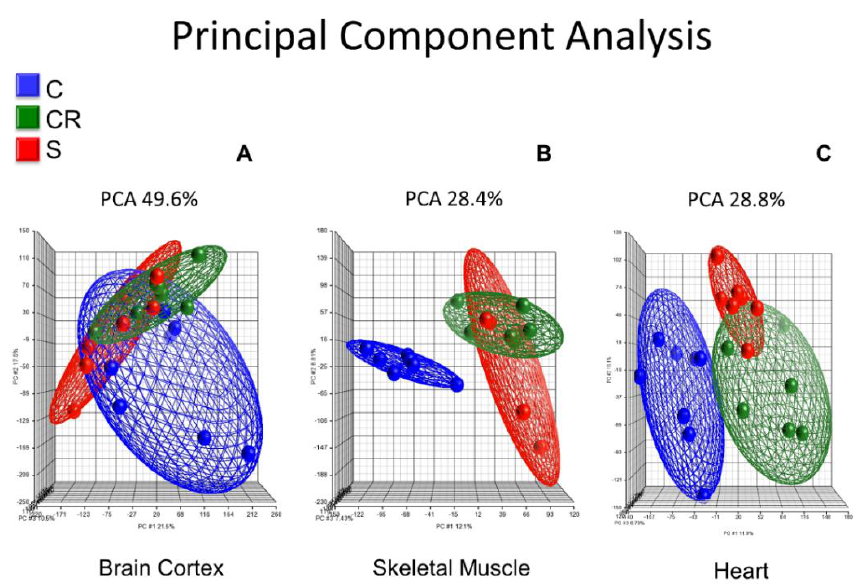
Figure 1. Principal component analysis of the whole transcriptome of old mice (C) (blue), old calorie restricted (CR) (green) and old supplemented with a calorie restriction mimetic micronutrient blend (S) (red) in brain cortex (Panel A), skeletal muscle (Panel B) and heart (Panel C). The percentage results of the sum of the three components (PC1, x -axis), PC2 ( y -axis), and PC3 ( z -axis) as indicated in the figure (% = PC1 + PC2 + PC3). The percentage of variability is 49.6% in brain cortex, 28.4% in skeletal muscle and 28.8% in heart.